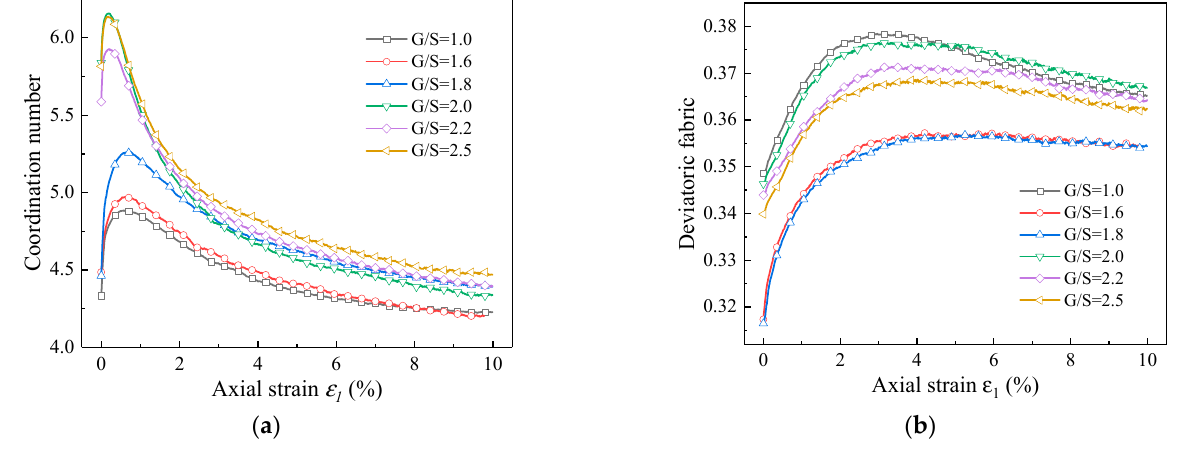
Figure 14. Model-predicted curves of ( a ) coordination number versus axial strain and ( b ) deviatoric fabric versus axial strain.